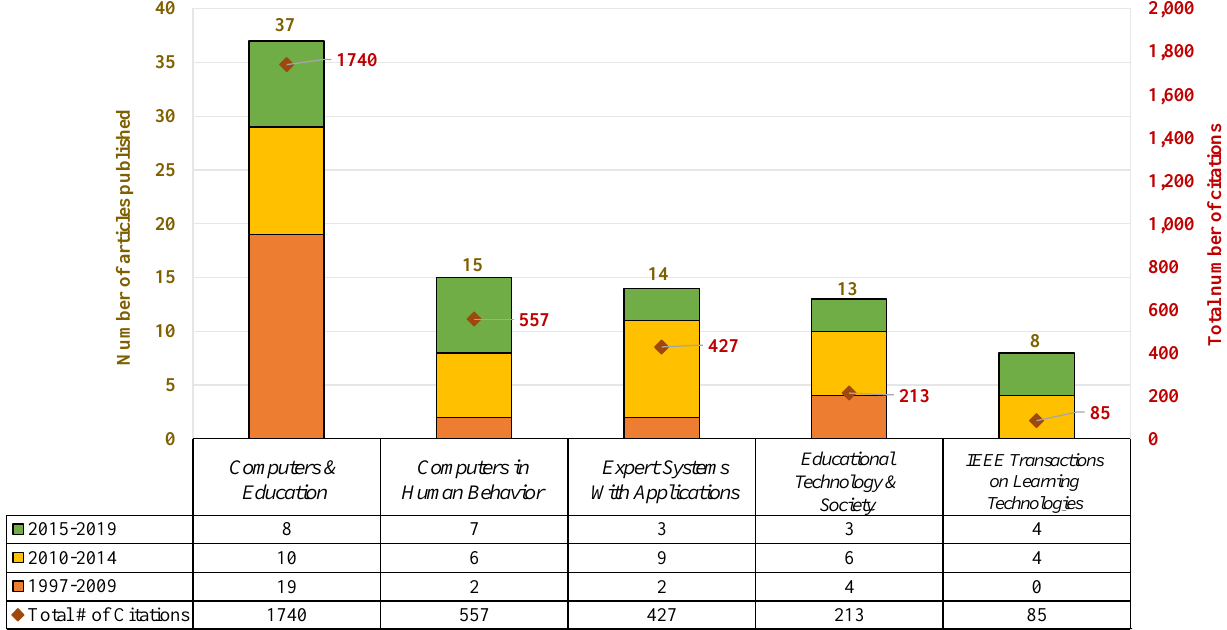
Figure 3 Top Five Journals by Total Number of Publications from 1997 to